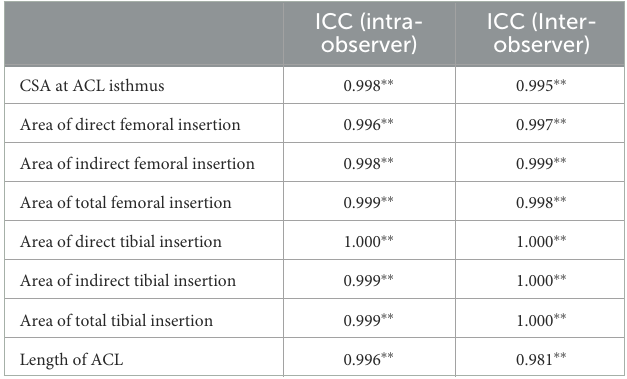
TABLE 1 Intraclass correlation coefficient (ICC) among intra- and inter- observer measurements.